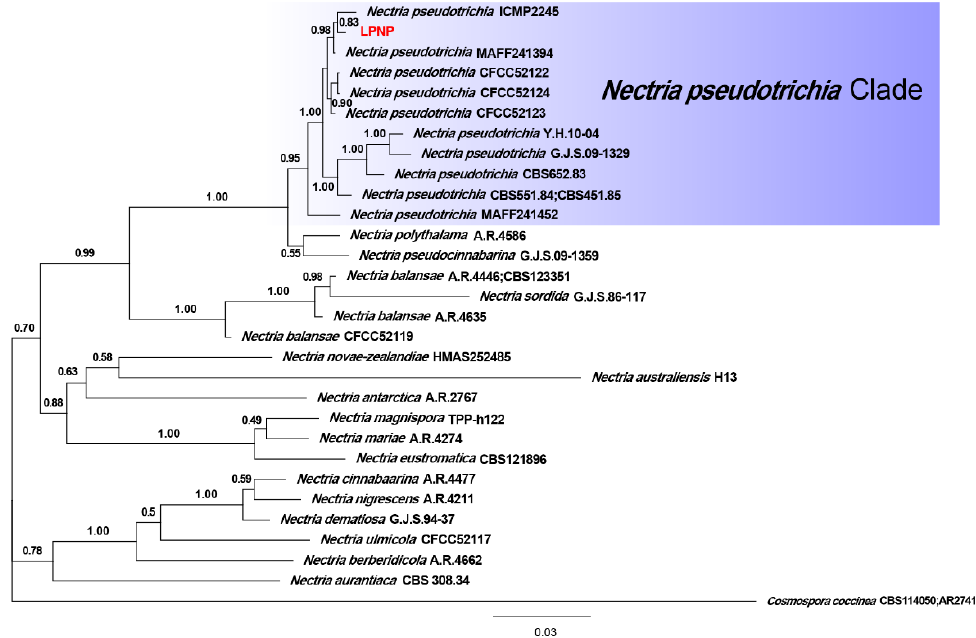
Figure 3. Phylogenetic tree inferred from BI analysis based on concatenated alignments of LSU rDNA, ITS rDNA, and tef1- α sequences. Cosmospora coccinea was used as an outgroup. Numbers on the nodes represent Bayesian posterior probabilities. The isolate obtained in the current study is highlighted in red.